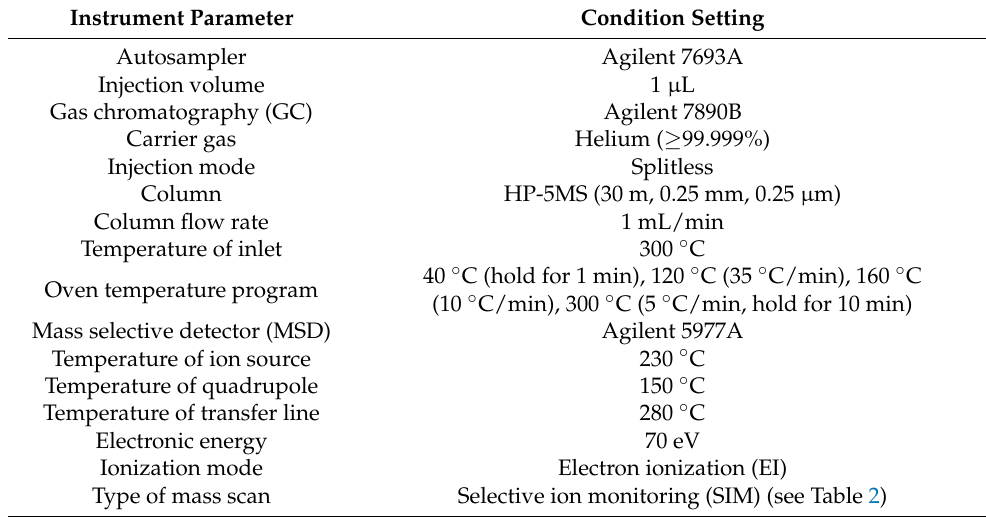
Table 1. The GC/MS system and operating conditions for PAHs analysis.